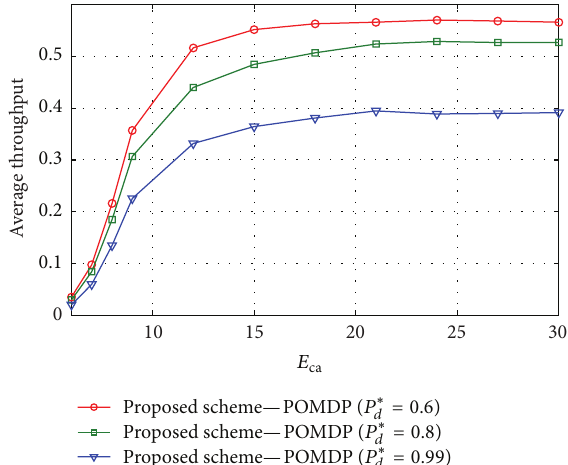
= {5, 7, 9} , 𝐸 = 10 , and 𝑒 ℎ = 2 . ca mean mean